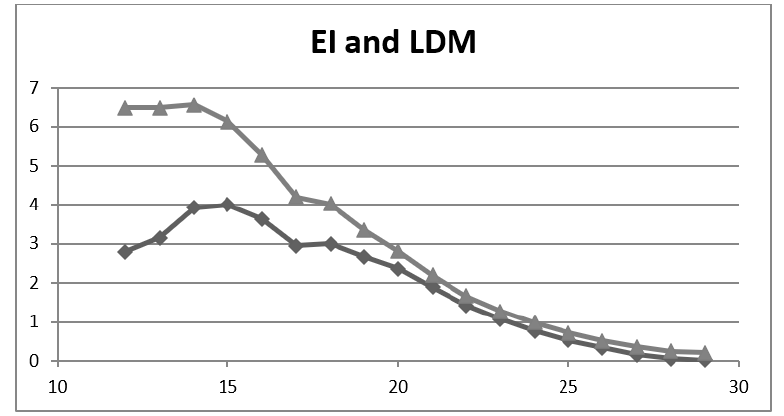
Figure 2. Plot of efficiency index (EI; upper line, triangles) and of likelihood to be diagnosed or misdiagnosed (LDM; lower line, diamonds) values (y axis) vs. MACE cut-off score (x-axis). Comparing the EI and LDM metrics across a range of P (Table 4, Figure 3) showed that values increasingly diverge at higher prevalence in this dataset. Table 4. EI and LDM values of MACE for dementia diagnosis at various prevalence levels at fixed test cut-off ( ≤ 20/30). P, P ′